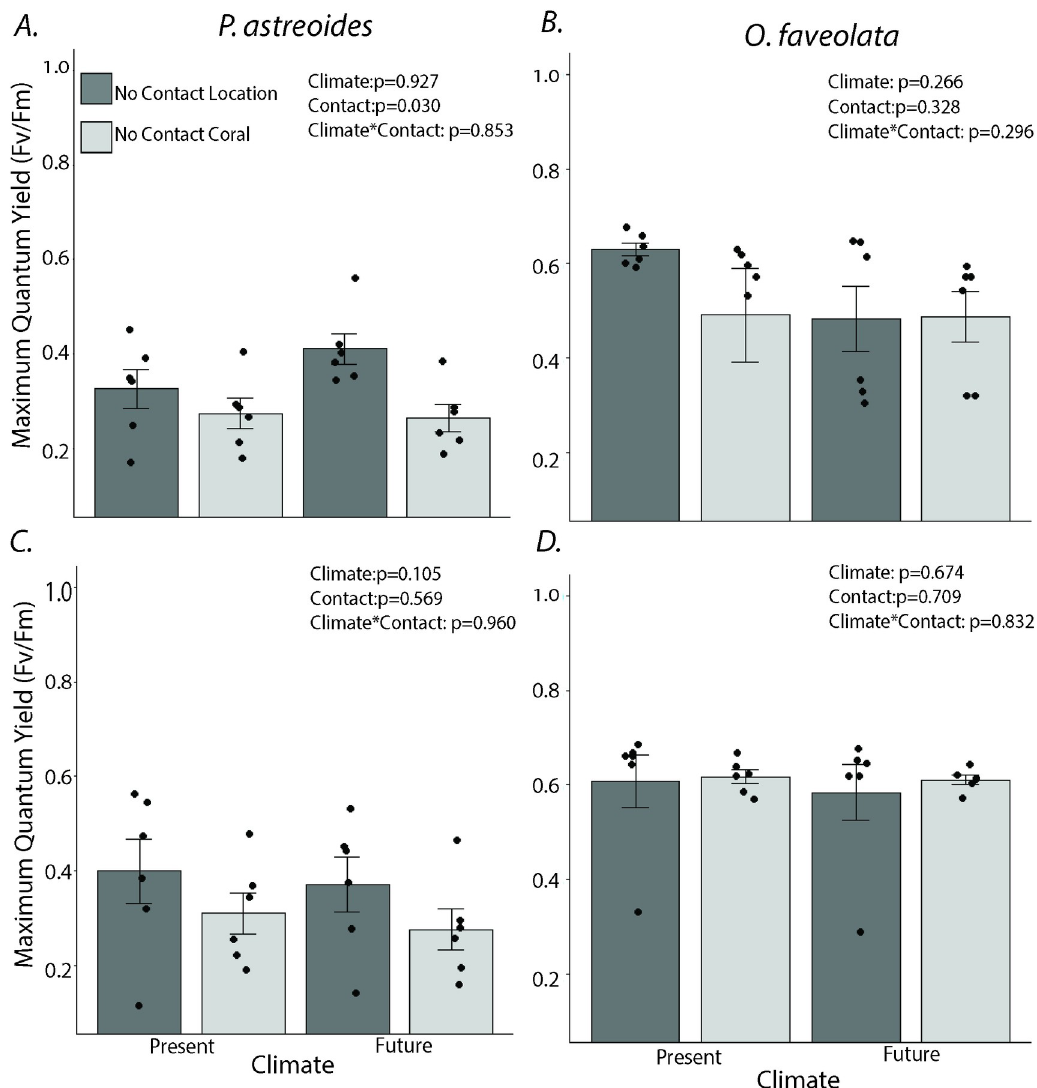
Fig 4. Effects of climate and coral-coral competition on maximum quantum yield (means ± SE) beyond areas of direct contact. Maximum quantum yield (means ± SE) for (A) Porites astreoides in contact with Orbicella faveolata ; measurement taken at the point 3 cm away from direct contact (No Contact Location) vs. a control P . astreoides fragment not in direct contact with O . faveolata (No Contact Coral) at day 7, (B) The same contrast but for O . faveolata in contact with P . astreoides , (C) P . astreoides in contact with O . faveolata : measurement taken at the point 3 cm away from direct contact (No Contact Location) vs. a control P . astreoides fragment not in direct contact with O . faveolata (No Contact Coral) at day 14, and (D) The same contrast, but for O . faveolata in contact with P . astreoides . Analyses by two-way ANOVA comparing contact and climate condition for each coral species. Dots show individual data points. N = 6.